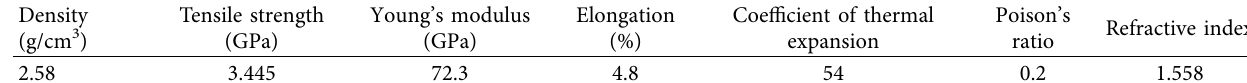
Table 2: Physical and mechanical properties of glass fibre (30).